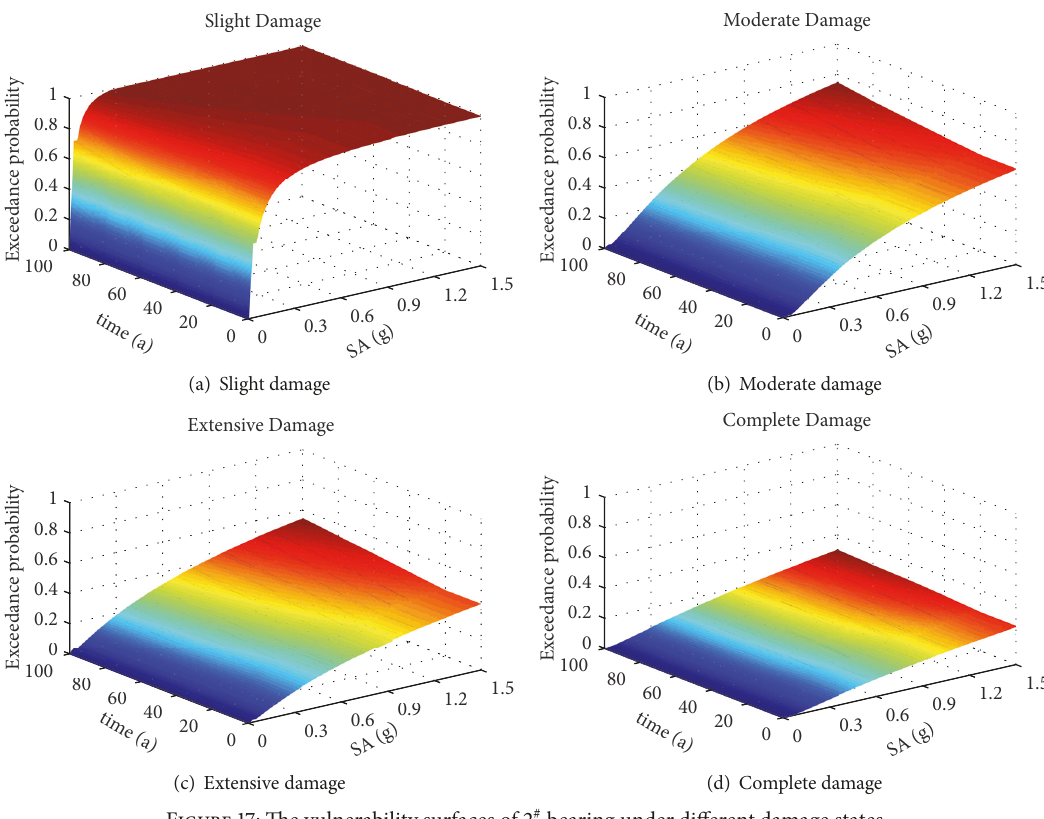
Figure 17: The vulnerability surfaces of 2 # bearing under different damage states.